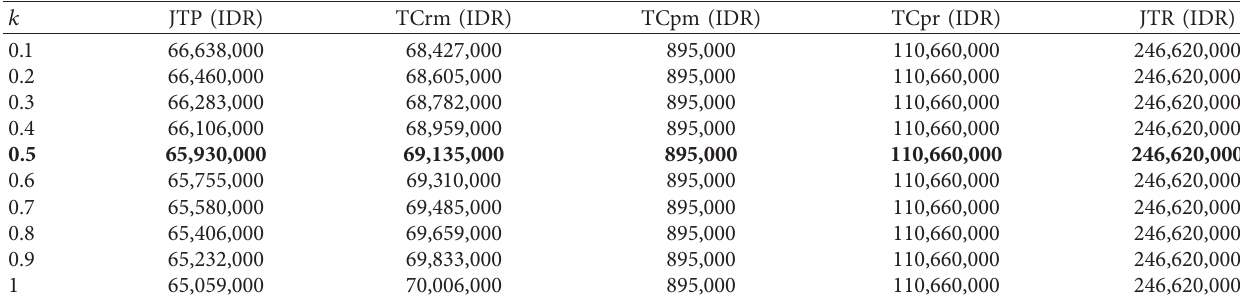
Table 6: Sensitivity analysis of the effect of k on cost, revenue, and